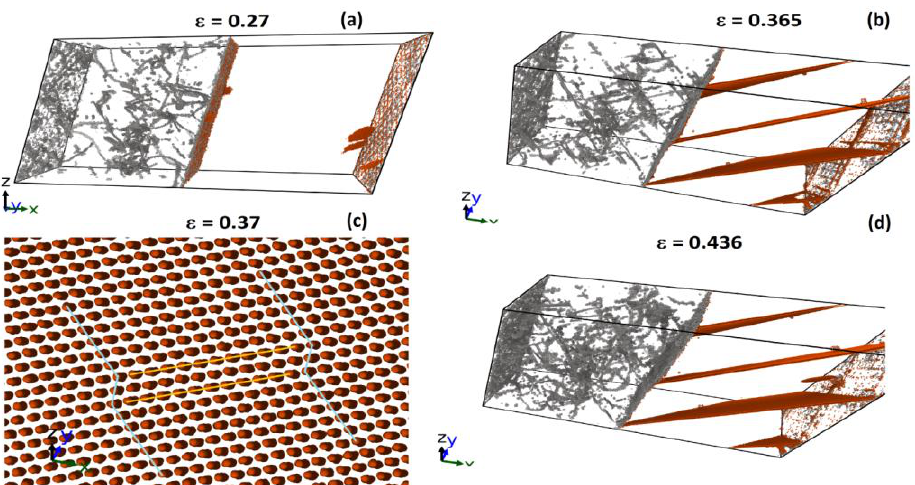
Figure 5. Development of plastic deformation in the copper part of the bisystem at initial pressure of 0 GPa; the following stages are shown: ( a ) the nucleation and emission of dislocations from the interface between materials; ( b ) the stacking faults fill the copper part of the system; ( c ) a twin layer along the stacking fault surface; ( d ) the nucleation of secondary dislocations from the interface between materials. Only atoms with a high value of the centrosymmetry parameter are shown. Aluminum atoms are grey colored, copper atoms are orange colored. The corresponding values of engineering strain 𝜀 are indicated in the figure.